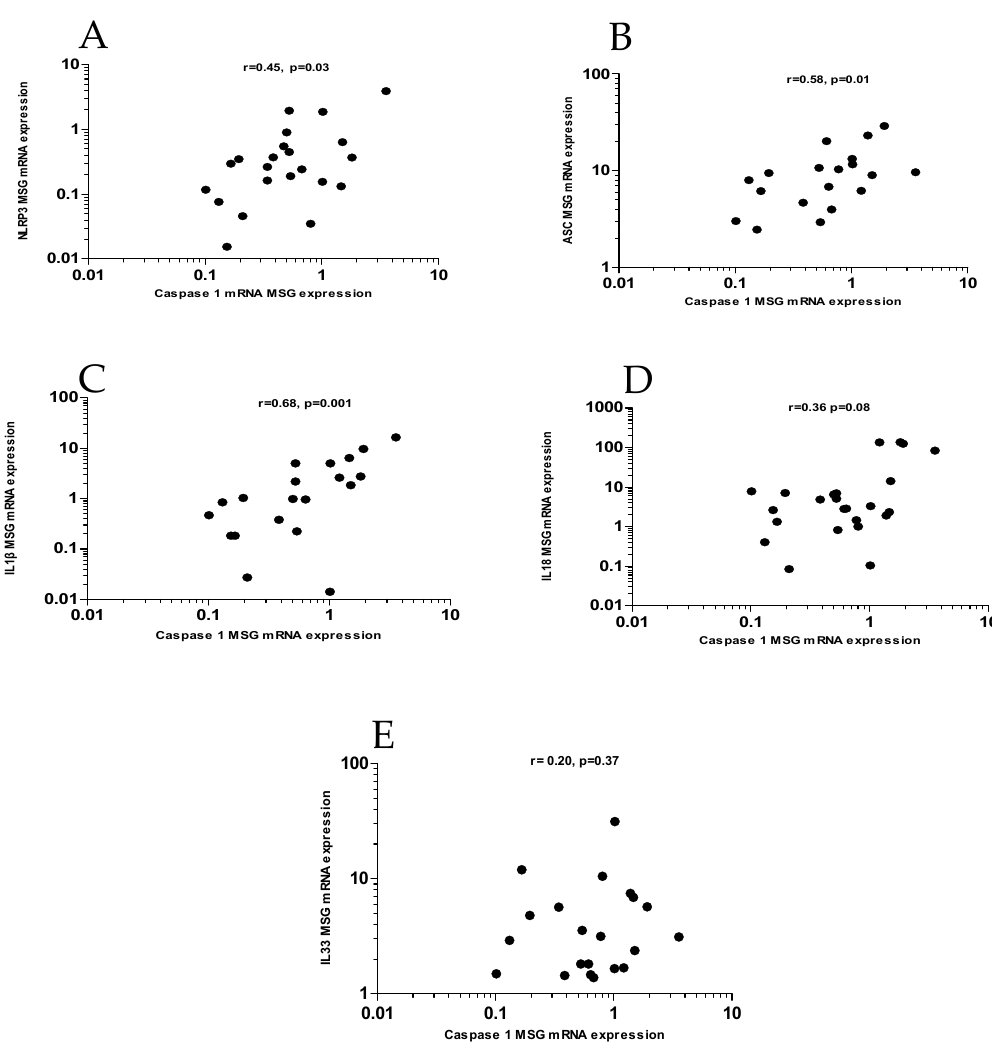
Figure 3. IGF1R transcripts, inflammatory apoptotic molecules, and inflammasome components in salivary gland tissues from patients with SS. Significant correlations between caspase 1 gene expression with NLRP3 (r = 0.45, p = 0.03) ( A ), ASC (r = 0.58, p = 0.01) ( B ), IL1β (r = 0.68, p = 0.001) ( C ). No associations between IL18 or IL33 with caspase 1 mRNA expression were detected ( D , E ). SS: Sjogren’s syndrome; MSG: minor salivary gland; NLRP3: NOD-like receptor pyrin domain containing 3; ASC: apoptosis-associated speck-like; r: Spearman’s